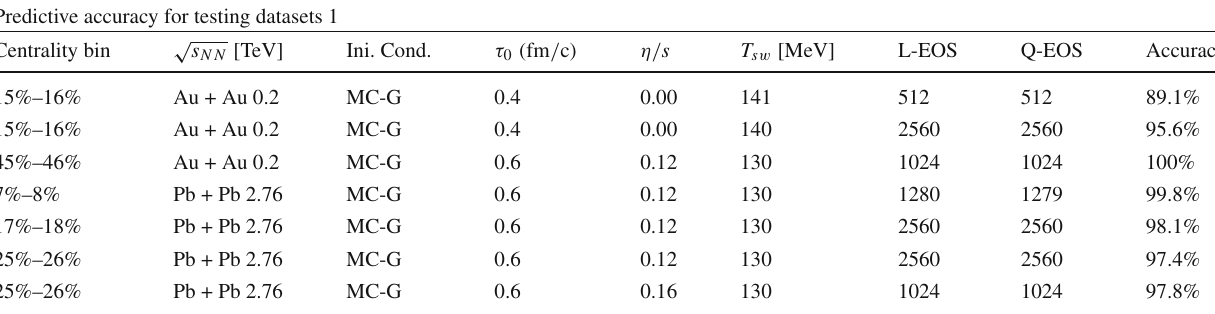
Table 4 Predictive accuracy on the testing datasets 1: 30-events-fine-averaged spectra ρ a ( p T ,(cid:6)) generated with MC-Glauber initial conditions √ s NN , η/ s , τ 0 , and T s w in the centrality range 0–50% and different